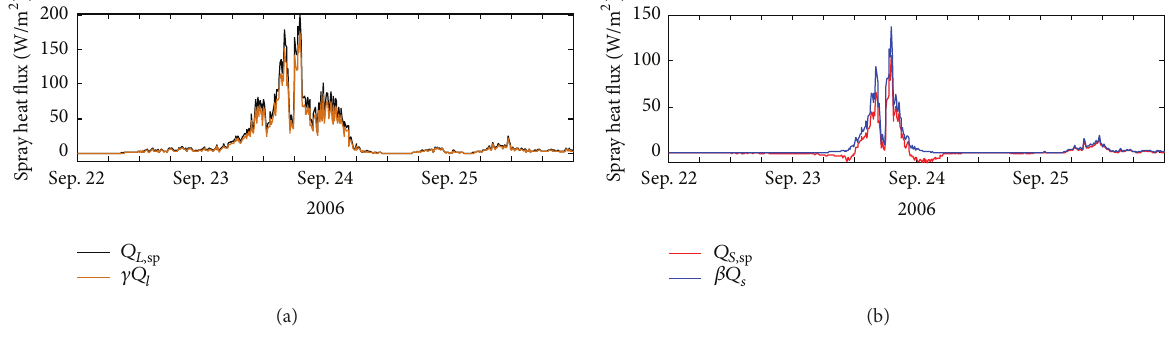
Figure 10: Time series of spray heat flux at the KEO station. Black line and orange line represent the sea spray mediated latent 𝑄 𝐿, heat flux of spray increased air-sea temperature different 𝑟𝑄 𝑙 in Figure 10(a), respectively. Red line and blue line indicate sea spray mediated flux and spray sensible heat 𝛽𝑄 𝑠 in Figure 10(b), respectively. sensible heat 𝑄 𝑆, sp